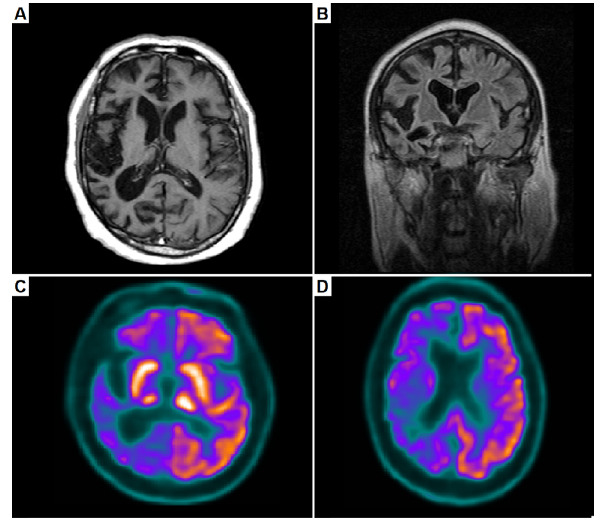
Figure 2. Brain magnetic resonance imaging – T1 axial (A) and coronal (B) reveal right-side atrophy; 18 F-FDG PET-CT (C and D) shows right-side